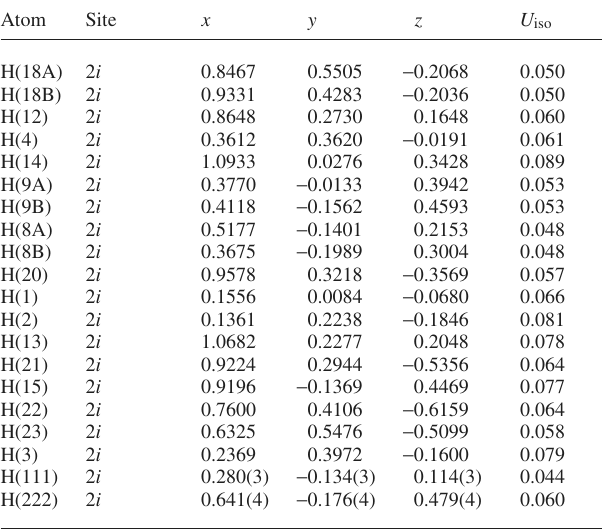
Table 2. Atomic coordinates and displacement parameters (in Å 2 )